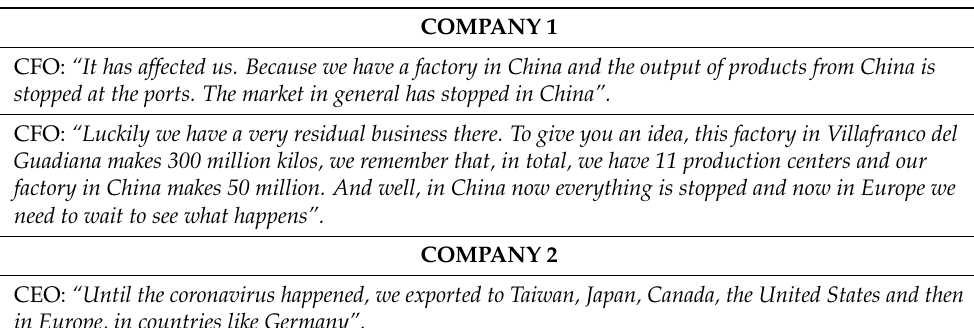
Table A2. Impact of COVID-19 on the companies